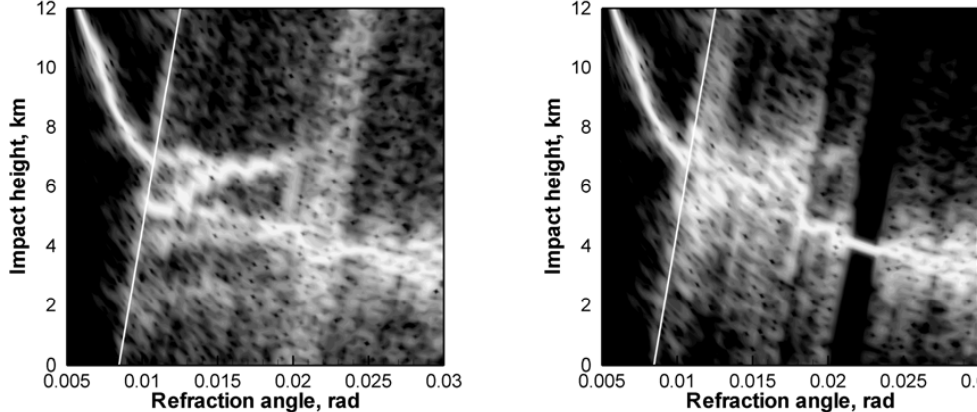
Fig. 4. Occultation event observed on 30 September 2007, UTC 00:12, 4.67S 25.31W. Left panel: merging mode RS+CL. Right panel: CL Figure 4. Occultation event observed on September 30, 2007, UTC 00:12, 4.67S 25.31W. Left 2 data only. The white line shows the border between the CL area and the RS+CL panel: merging mode RS+CL. Right panel: CL data only. The white line shows the border 3 between the CL area and the RS+CL area. 4